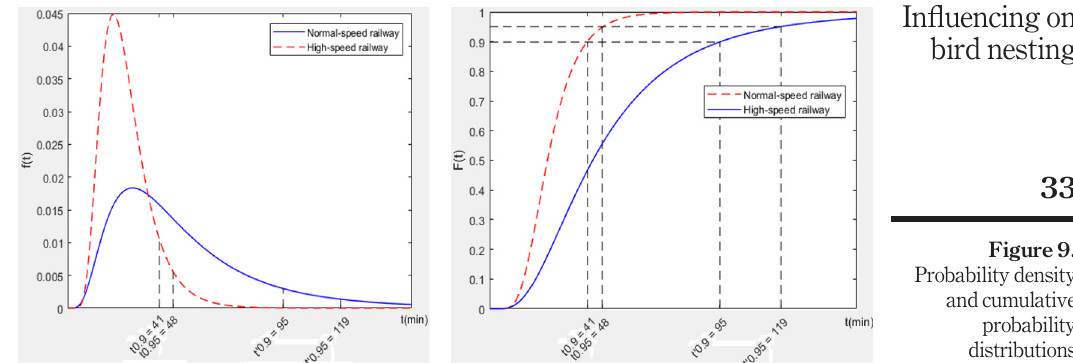
Figure 9. Probability density and cumulative probability